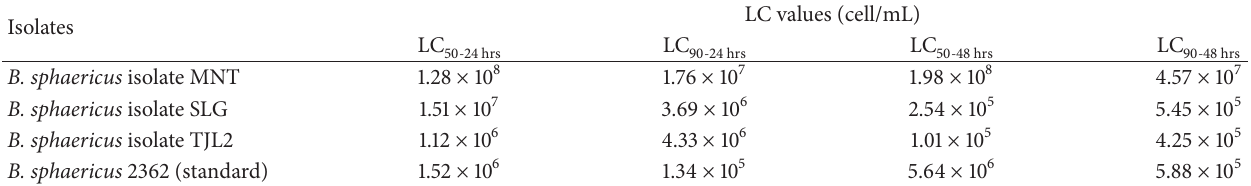
Table 2: LC value of B. sphaericus isolated from Lombok Island against An. aconitus and its comparison with B. sphaericus 2362.